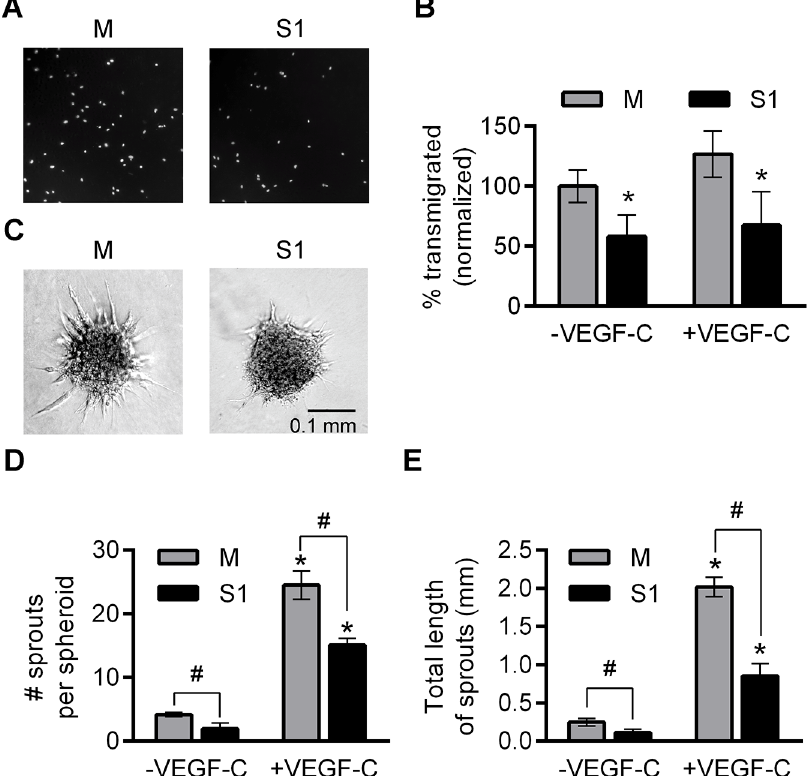
Fig 4. ADAM17 silencing decreases lymphatic endothelial cells (LEC) migration and sprouting. ( A ) Fluorescent images of DAPI-labeled M and S1 that transmigrated through a 3D Matrigel/collagen I matrix. ( B ) Quantification of M and S1 that transmigrated through a Matrigel/collagen I matrix during 16-h incubation in the absence or presence of 100 ng/ml VEGF-C, normalized to untreated M. Bars represent mean ± SD from at least three independent experiments, each analyzed from four microscopic fields per group. * P < 0.05 vs M, untreated- or treated with VEGF-C, respectively. ( C ) Representative bright field images of sprouting spheroids formed by M and S1 embedded in collagen gel. ( D, E ) Effect of ADAM17 silencing on sprouting of LEC spheroids reflected by the changes in: ( D ) Number of sprouts and ( E ) Total length of sprouts. Bars represent mean ± SD from three independent experiments in which at least 10 spheroids per group were analyzed * P < 0.01 vs appropriate cell line not treated with VEGF-C; # P < 0.05 vs M, untreated- or treated with VEGF-C,